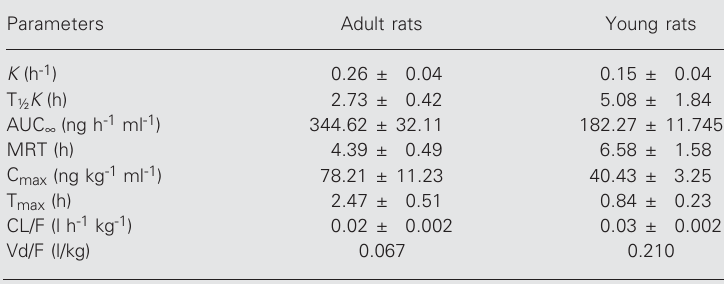
Table 2. Pharmacokinetic parameters determined after subcutaneous injection of 6 µg 99m Tc-TsTX into adult (150-160 days old) and young (21-22 days old) male rats, with correction for body